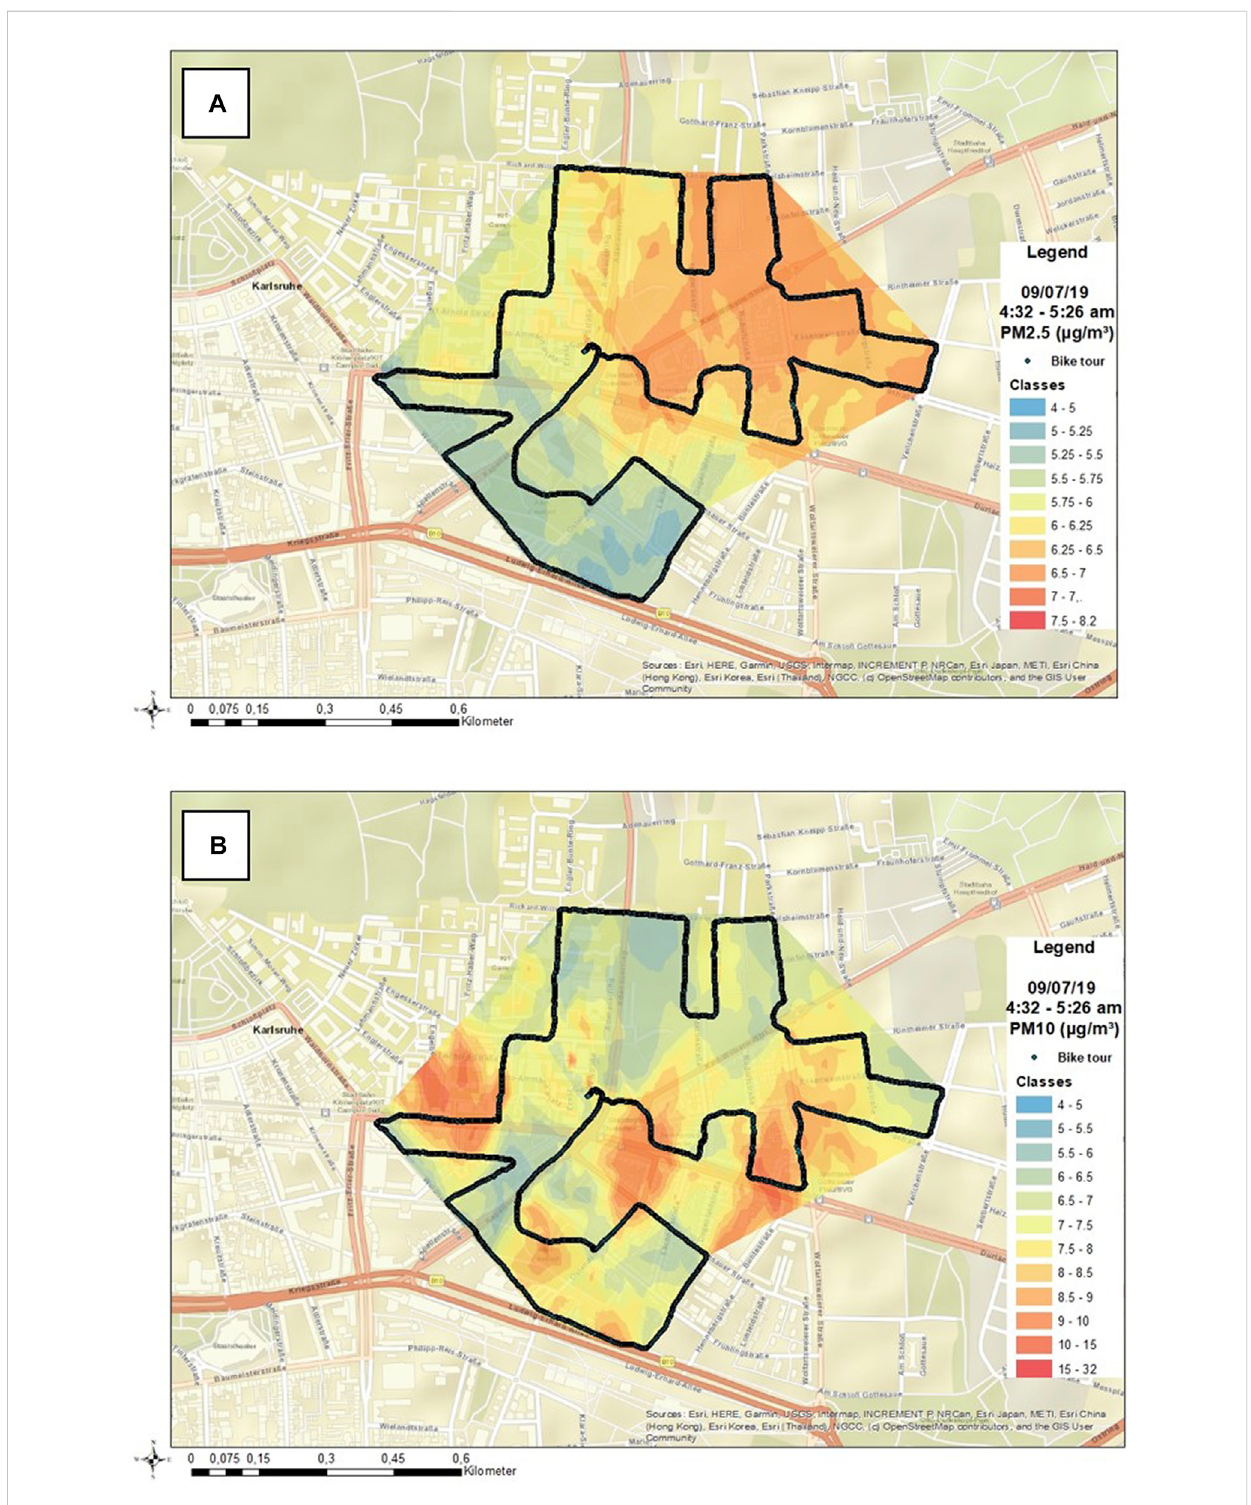
FIGURE 7 (A) PM 2.5 concentration pattern on 9th of July 2019, 4:32